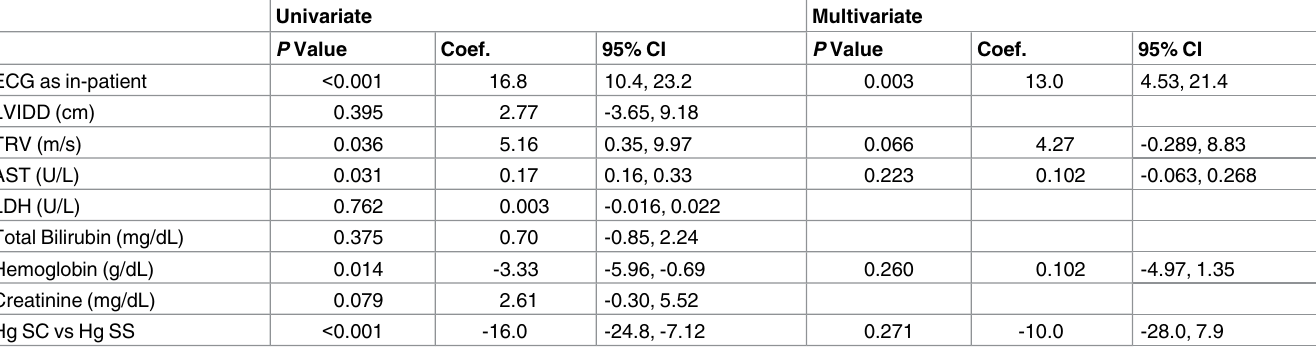
Table 1. Univariate and multivariate regression analysis for QTc in the UIC Cohort. Univariate